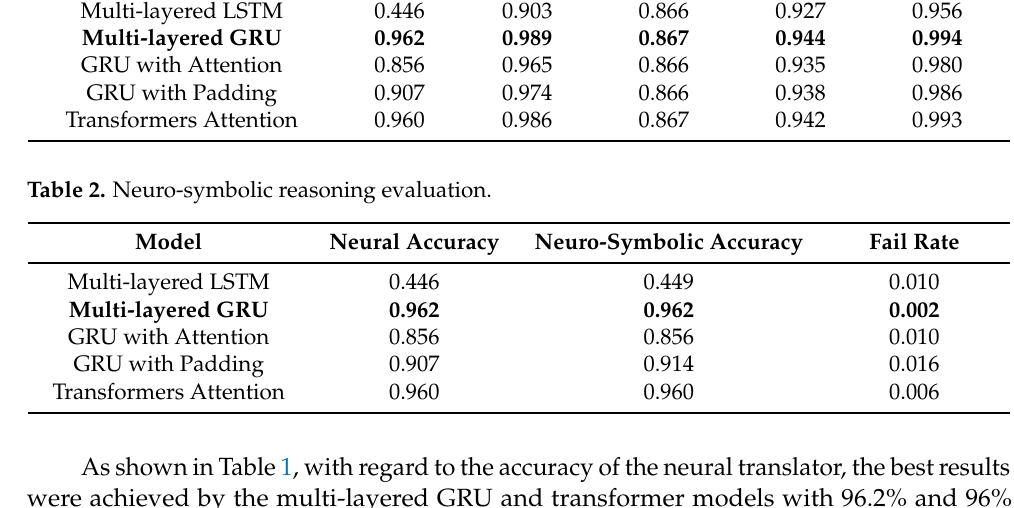
Table 1. Neural translator evaluation. Model